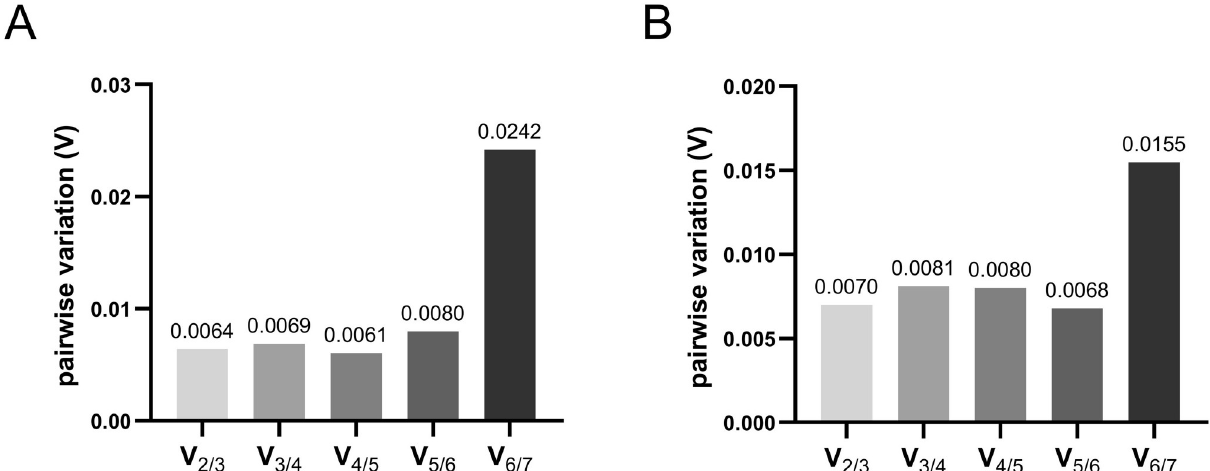
Fig 4. Determination of minimal number of reference genes for accurate normalization. Pairwise variations (V n/n+1 ) were calculated by geNorm in all samples (eggs and isolated egg cortices) for total RNA (A) and mRNA (B).